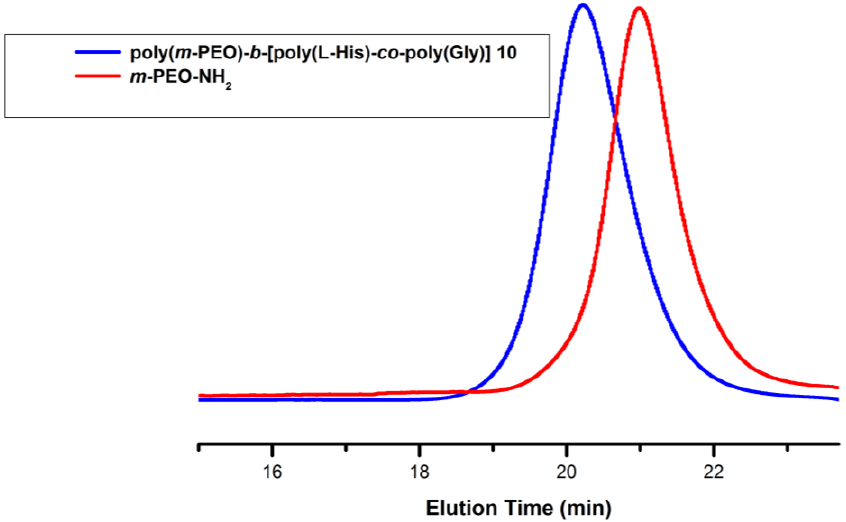
Figure 4. SEC eluogram of m -PEO- b -poly(His- co -Gly) with 10% glycine to histidine molar ratio.